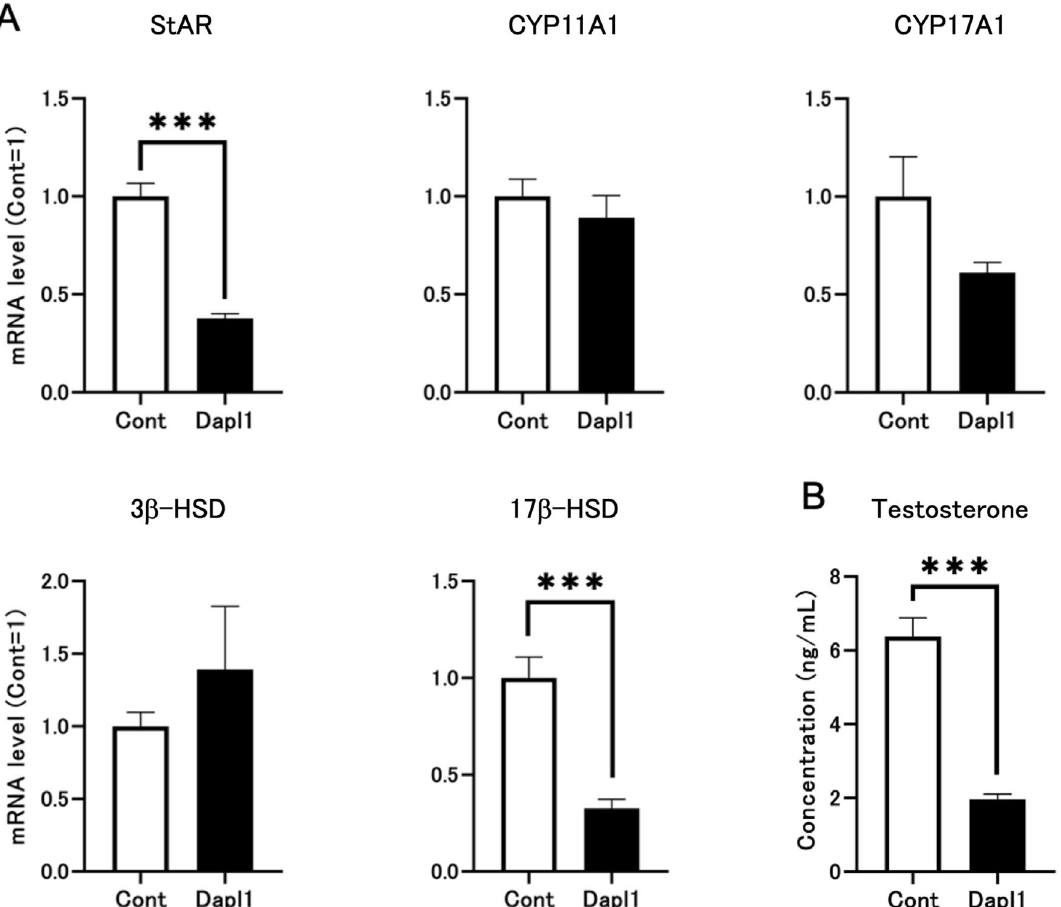
Figure 5. Effects of Dapl1 transfection on neutral steroid hormone synthesis in I-10 cells. ( A ) Effect of Dapl1 transfection on the testicular steroidogenesis gene-expression of mRNA coding for StAR, CYP11A1, CYP17A1, 3β-HSD, and 17β-HSD in I-10 cells. I-10 cells seeded in 6-well plates were transfected with pcDNA3.1-mouse Dapl1 (2 µg/well). For the control, cells were transfected with the empty pcDNA-3.1(−)-hygro vector. Each bar represents the mean ± standard error of the mean (S.E.M.) of 6 samples. ( B ) Effect of Dapl1 transfection on level of testosterone in I-10 cell culture medium. Each bar represents the mean ± S.E.M. of 8 samples. Significantly different from the control I-10 cells: ***p < 0.001. DAPL1 death-associated protein-like 1, StAR steroidogenic acute regulatory protein, CYP cytochrome P450, 3β-HSD 3β-hydroxysteroid dehydrogenase, 17β-HSD 17β-hydroxysteroid dehydrogenase, SRD5A1 steroid 5α-reductase 1, SRD5A2 steroid 5α-reductase 2, PND49 postnatal day